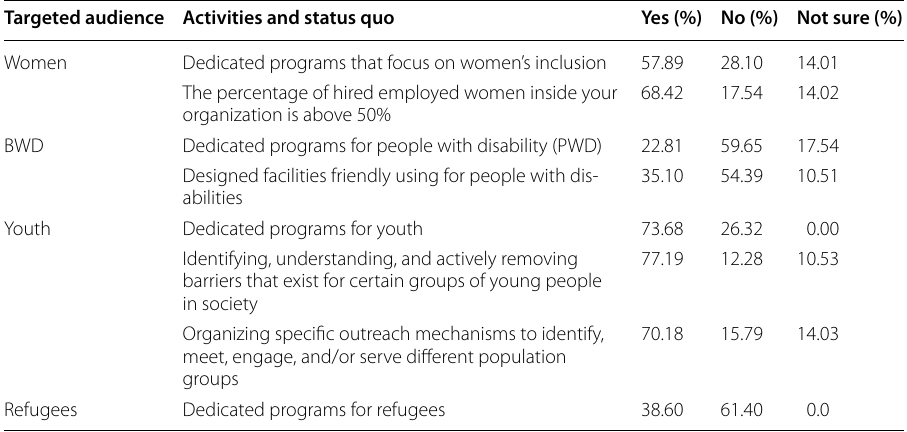
Table 11 Percentage distributions of the SESO’s activities in Jordan for women, people with disability (BWD), youth and refugees Targeted audience Activities and status